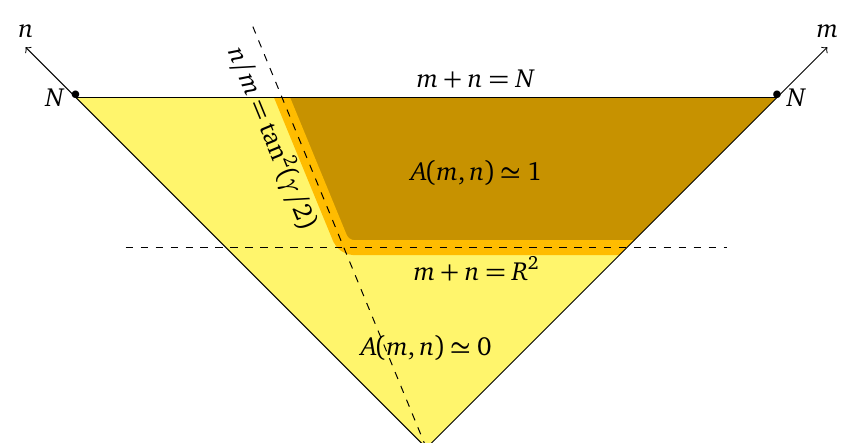
Figure 13: A rough density plot of the overlap eigenvalues (31) in the triangle 0 ≤ m + n < N (cid:29) 1. Throughout the yellow region, A ( m , n ) nearly vanishes. Con- versely, in the brown patch, the overlap is almost complete. In the transition region (thick orange line), A ( m , n ) interpolates from zero to one; this region gives the main contribution to entanglement entropy (32). Note the similarity with figs. 4 and 12: the spatial location of low-energy states (10) is specified by their quantum numbers ( m , n ) , and states for which m + n and m are both ‘large enough’ are entirely con- tained in the spherical cap (27), while those that do not satisfy this criterion are well outside the cap. The one-particle states that actually contribute to entanglement are localized on the cap’s